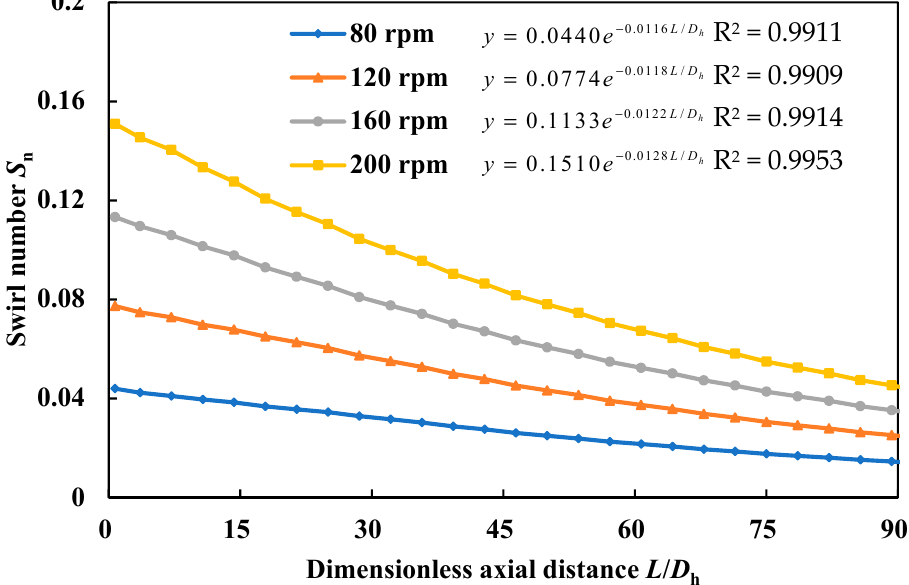
Figure 4. Variation curve of swirl number along the flow direction with different rotational speeds for the straight blade at α = 0°.